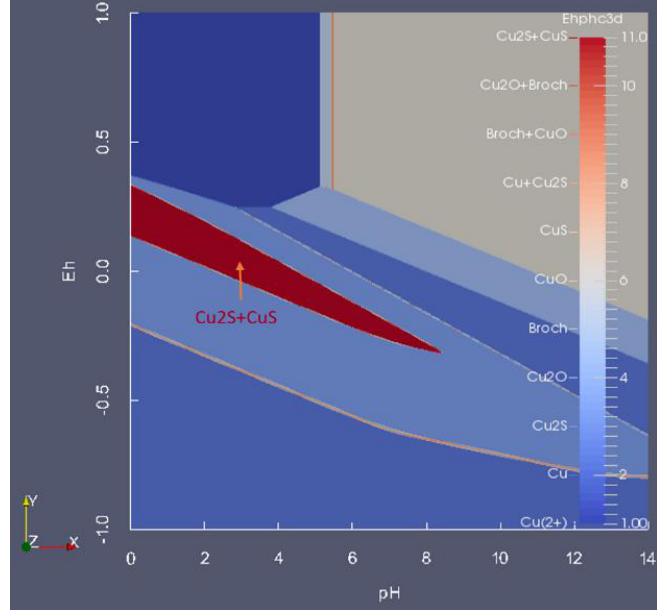
Figure 36. ParaView of Cu–S–water, where Σ Cu = 0.001 and Σ S = 0.0009 M. See the 2D plot of Figure 11 for a comparison.